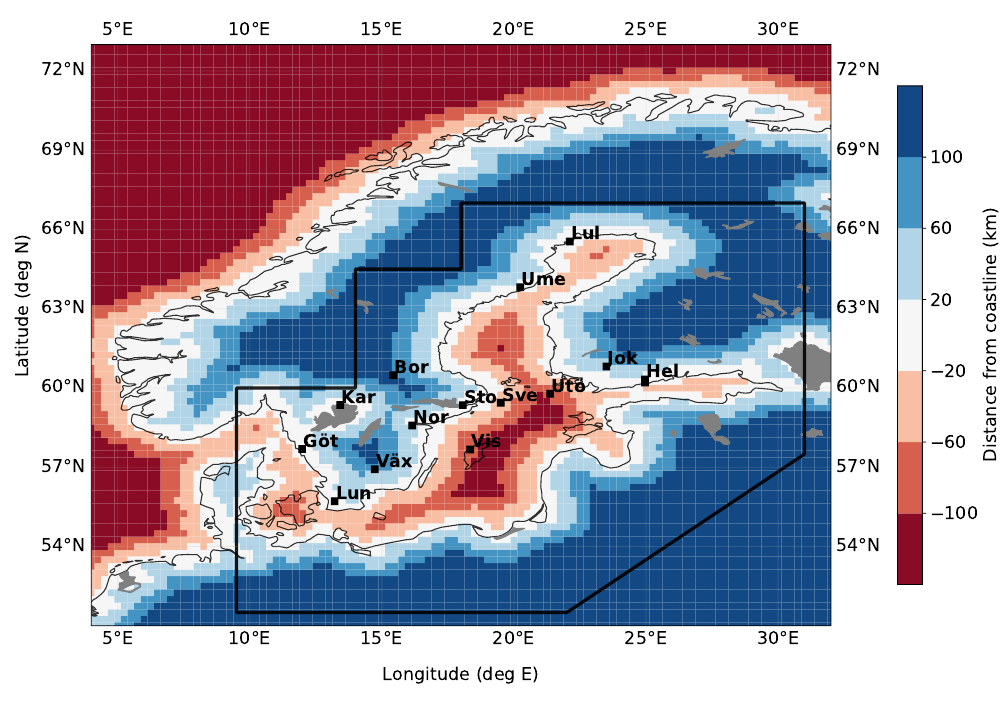
Figure 1. Map of the Baltic region included in this study, bounded by the black line. The color scale indicates the distance to the coastline of the CLARA satellite grid and the black filled squares represent the ground-based measurement